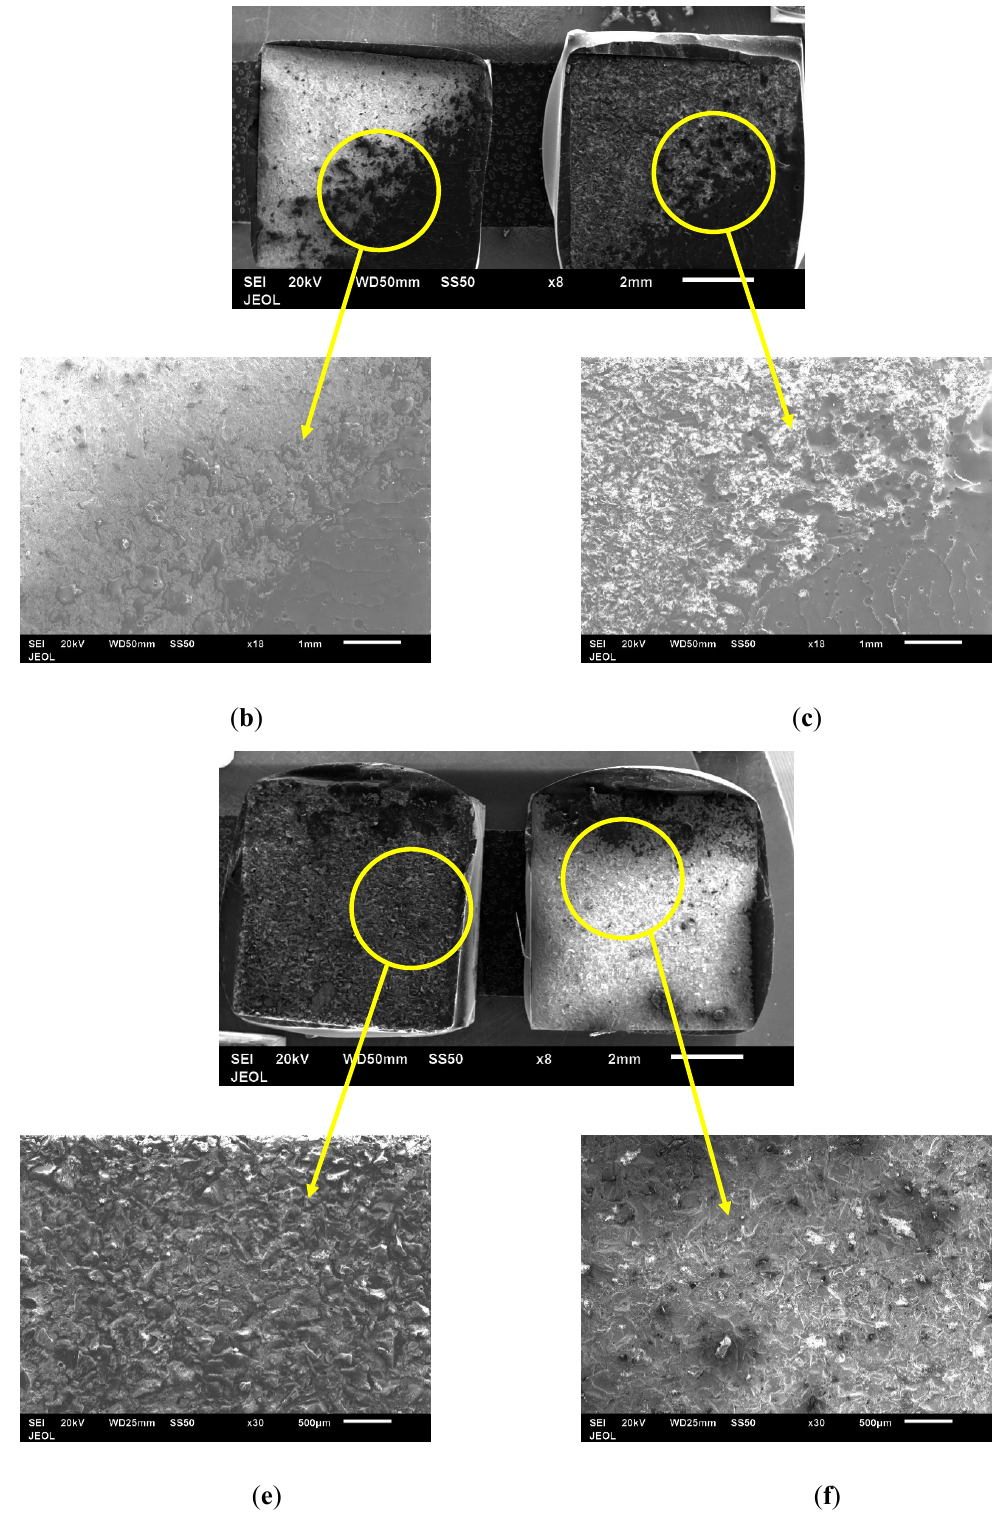
Figure 20. SEM images of coating/substrate interface after tensile test of two coatings; WC-12Co: ( a – c ); WC-10Co-4Cr: ( d – f